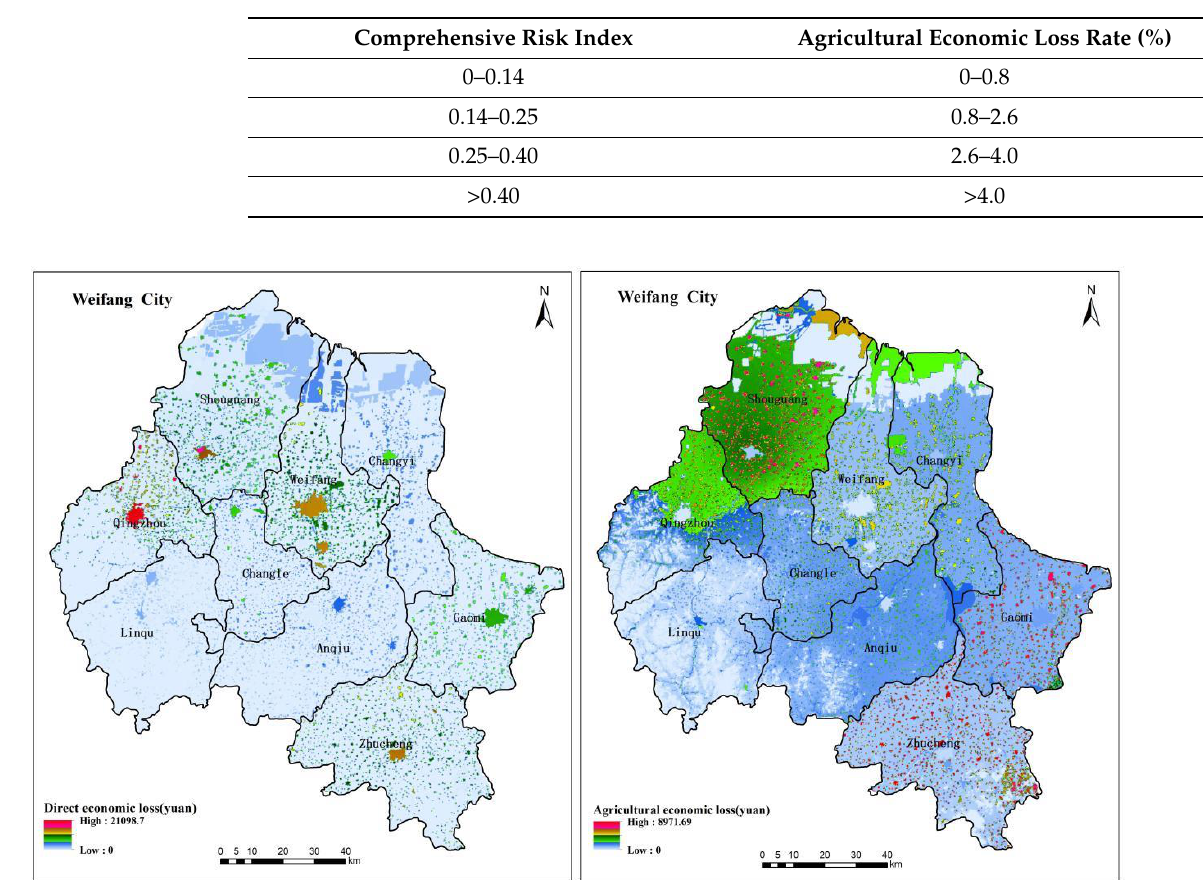
Figure 4. Correlation between flash flood CRIs and AELRs. Table 4. Distribution of flash flood CRI intervals and the AELR intervals in Weifang.